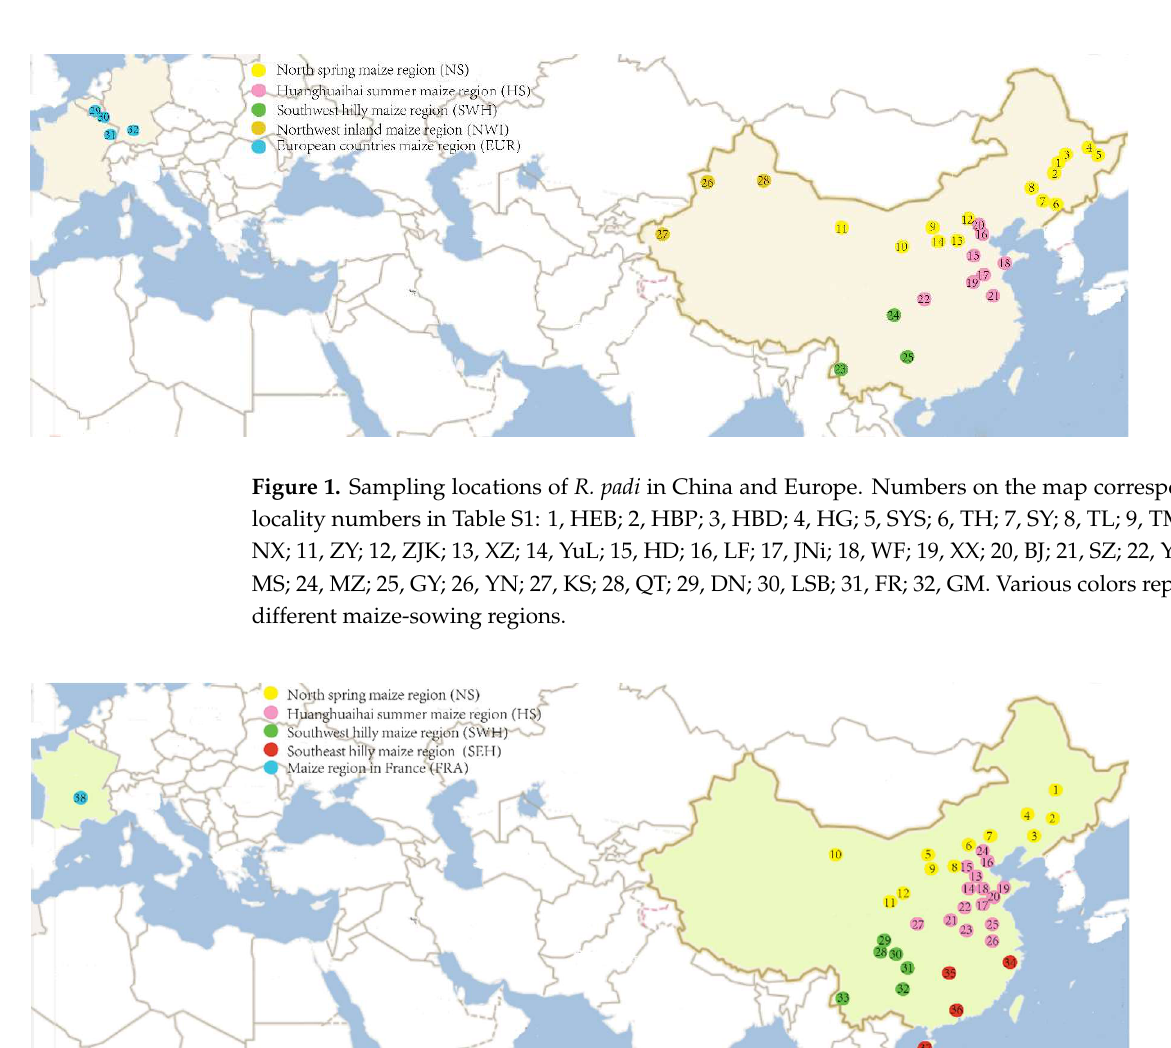
Figure 2. Sampling locations of R. maidis in China and France. Numbers on the map correspond to